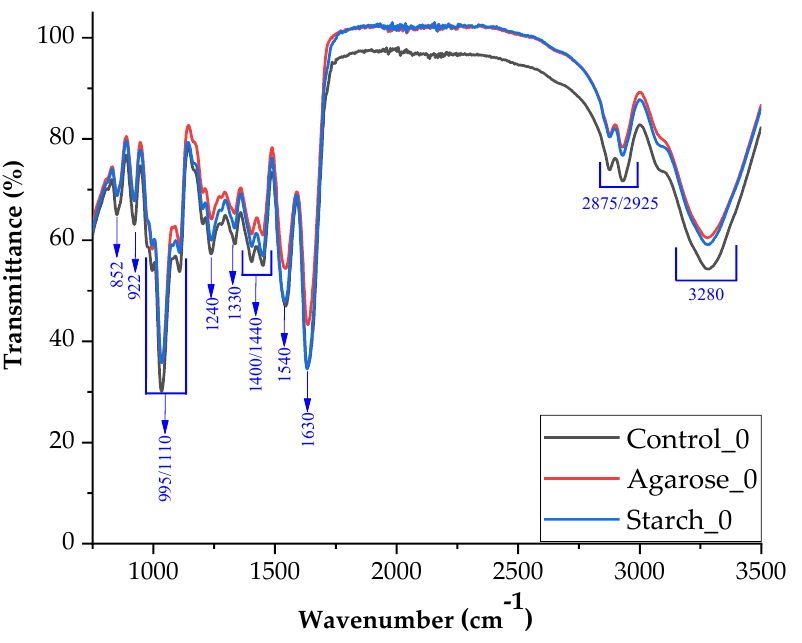
Figure 5. FTIR spectra of samples control and with additives (starch, agarose) in neutral pH.